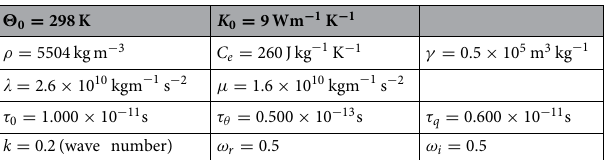
Table 1. Values of the geometrical and the material parameters for the half-space.